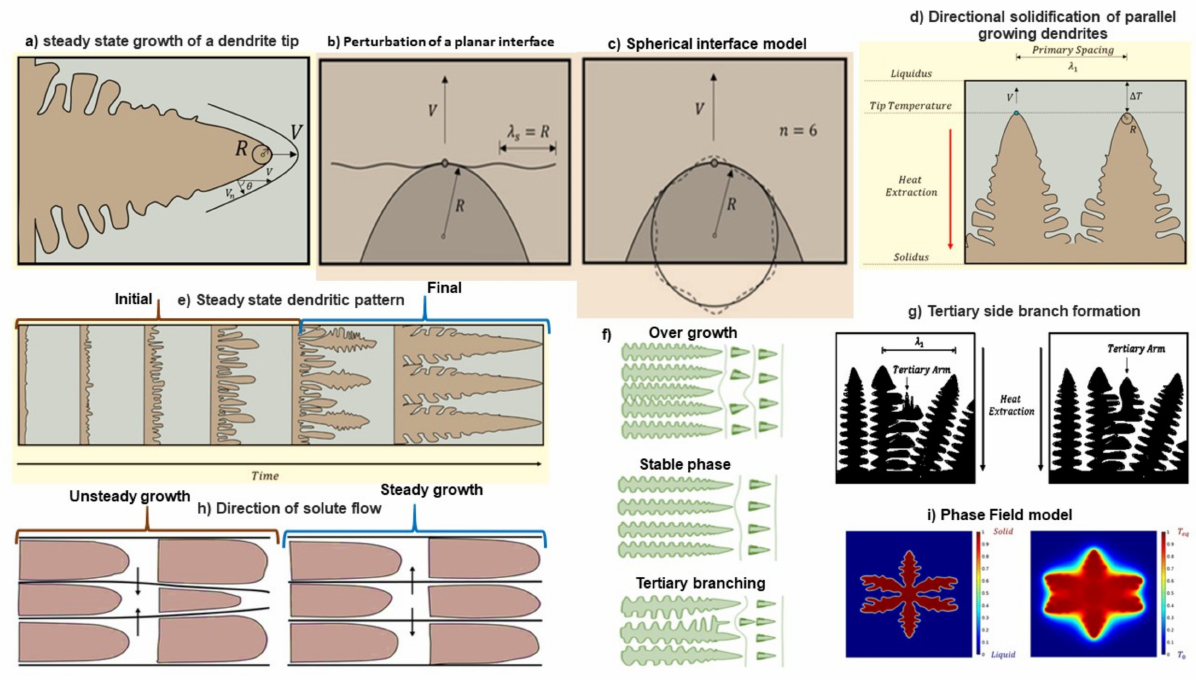
Figure 15. ( a ) Steady state growth mechanism of dendrite tip ( b ) Illustration of perturbation of planar surface ( c ) Depiction of dendrite growth according to ( d ) Directional solidification of dendrites ( e ) Steady state growth pattern ( f ) Stable, over growth dendrite depiction ( g ) Tertiary branching of dendrites ( h ) Solute flow direction for steady and unsteady growth ( i ) Phase field model simulation showing dendrite growth (adapted with permission from [181]. Crystals, MDPI,